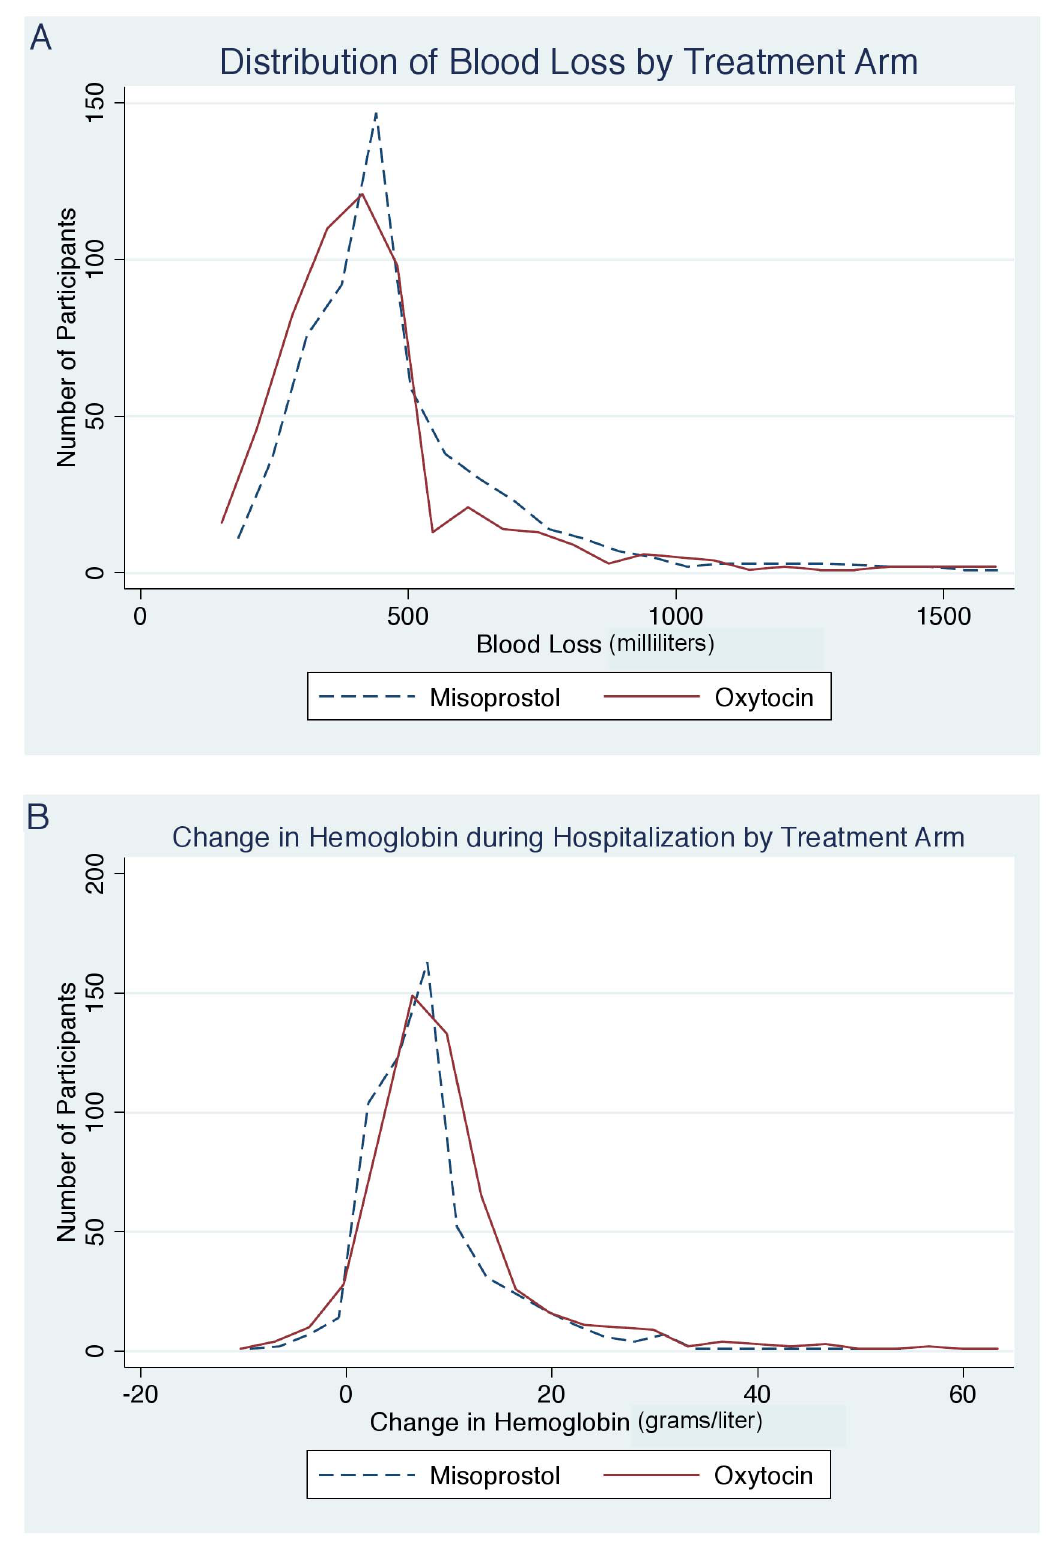
Figure 2. Distribution of blood loss and hemoglobin change by treatment arm. (A) Distribution of blood loss by treatment arm. (B) Change in hemoglobin during hospitalization by treatment arm.